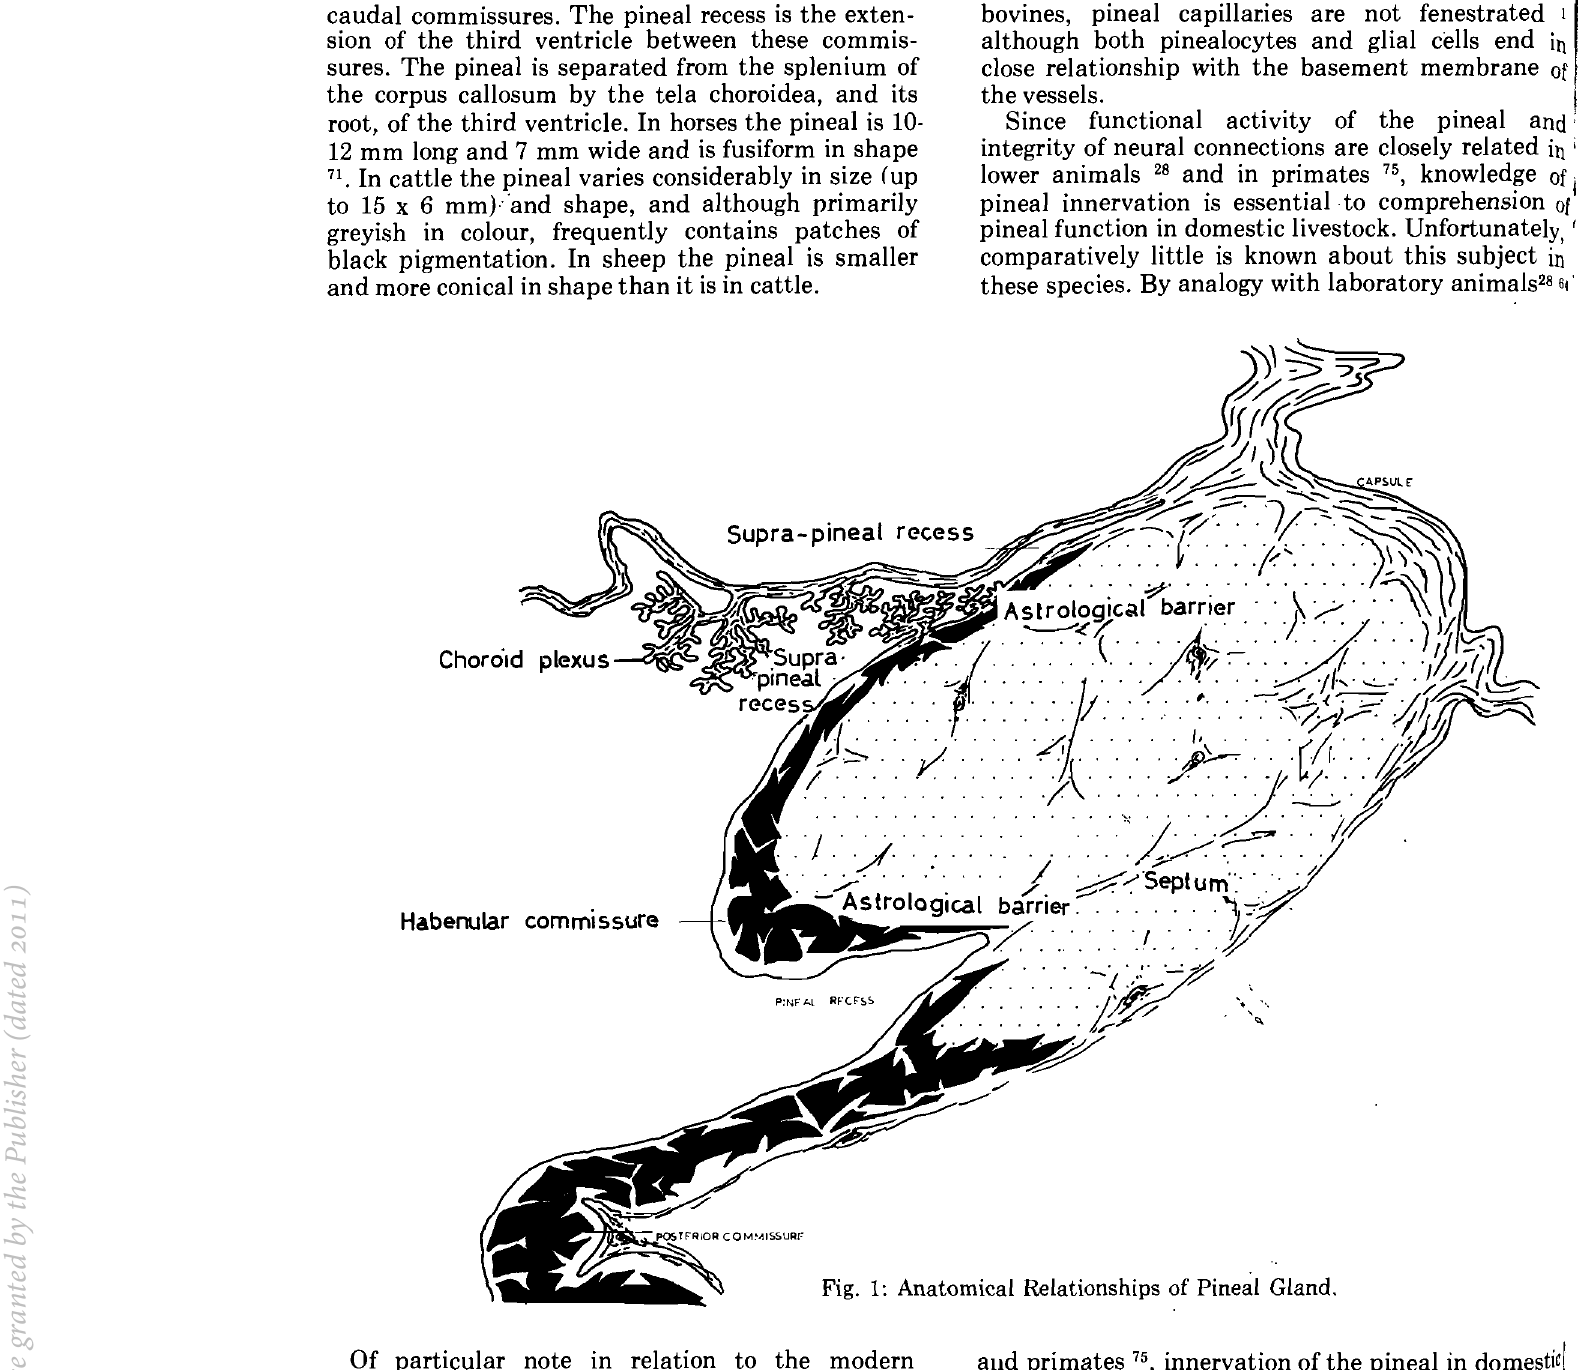
Fig. 1: AnatomicaL ReLationships of PineaL